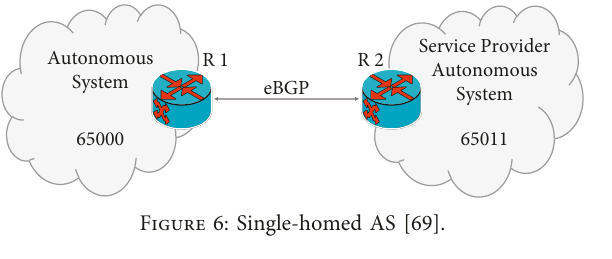
Figure 6: Single-homed AS